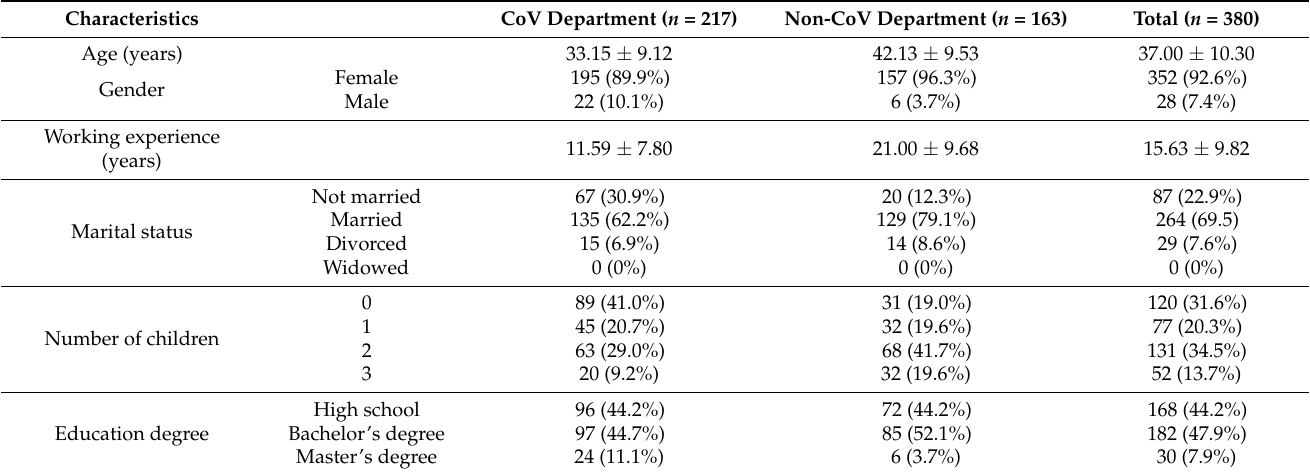
Table 1. Demographic data of the